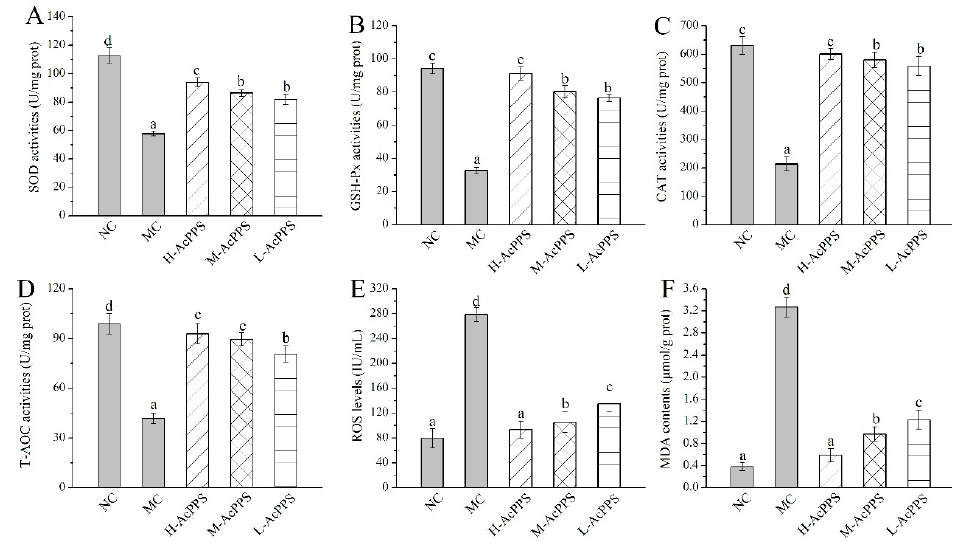
Figure 3. E ff ects of AcPPS on oxidative stress of lung in acute lung injury (ALI) mice. ( A ) SOD, ( B ) GSH-Px, ( C ) CAT, ( D ) T-AOC, ( E ) ROS, and ( F ) MDA. The values are reported as the Mean ± S.D. ( n = 10 for each group). Means with the same letter are not significantly di ff erent ( p <